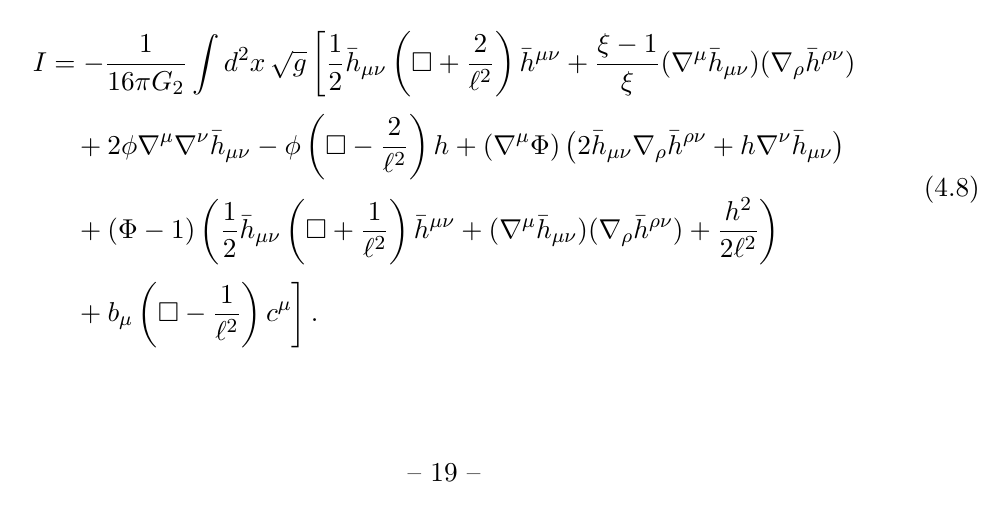
Figure 2 . The spectrum of various types of Euclidean AdS m 2 = 2 . The quadratic holomorphic di(cid:11)erentials are zero modes in the extremal limit, so they ‘ 2 dominate (cid:12)nite-temperature